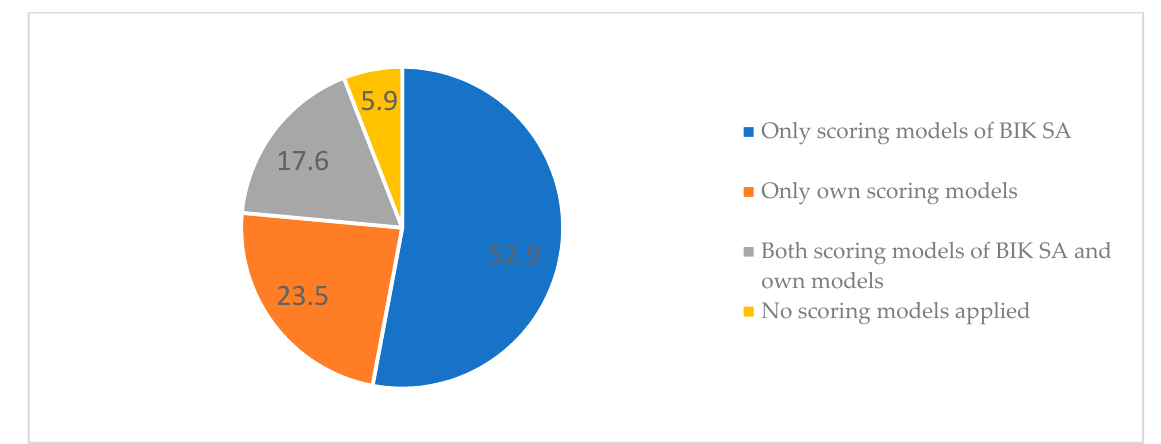
Figure 3. Source of scoring models used in the credit risk mitigation process in banks affiliated with BPS S.A. (%).